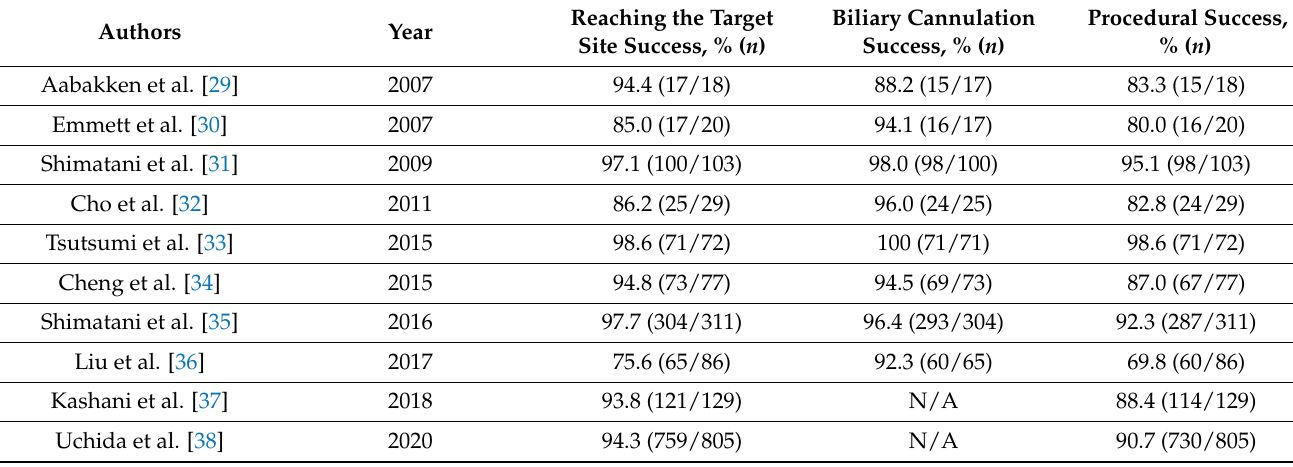
Table 3. Outcomes of double balloon endoscopy (DBE)-assisted ERCP procedure in patients with surgically altered anatomy